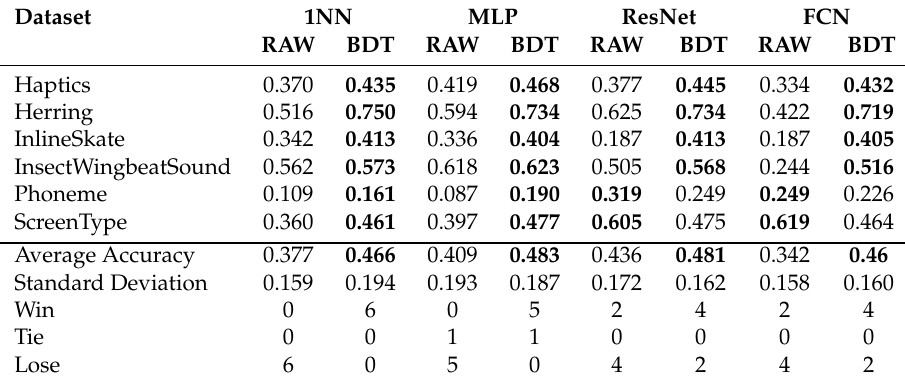
Table 3. Overall TSC